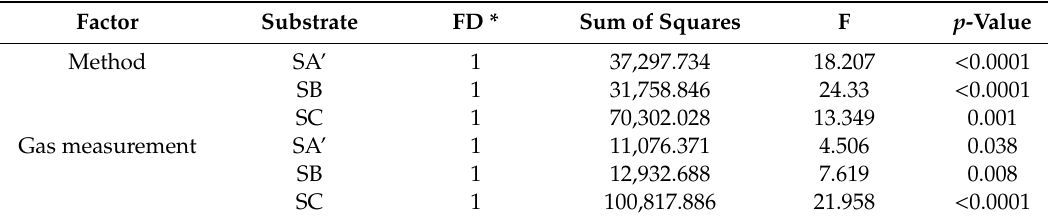
Table 10. Size of ANOVA with 4 factors for SA’, SB and SC.